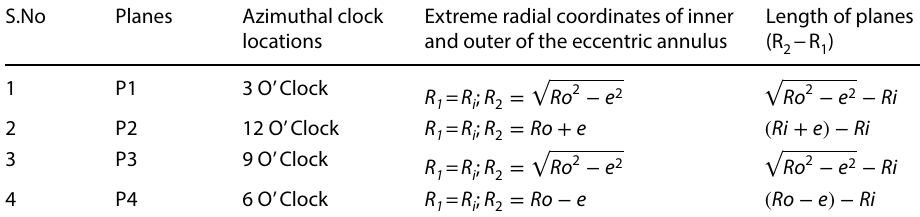
referenceS.No Planes Azimuthal clock